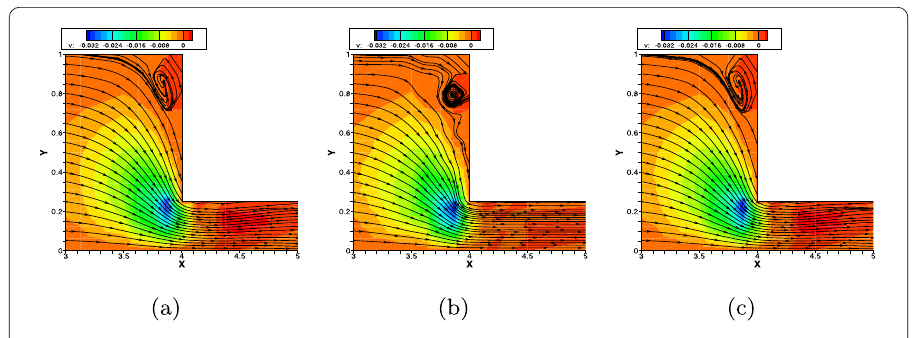
Figure 4 Streamlines and magnitudes of the velocity u . ( a ) Standard FE p 1 b – p 1 – p 1 dg triples; ( b ) FE p 1 – p 1 – p 1 dg triples without stabilization term; ( c ) FE p 1 – p 1 – p 1 dg triples with stabilization